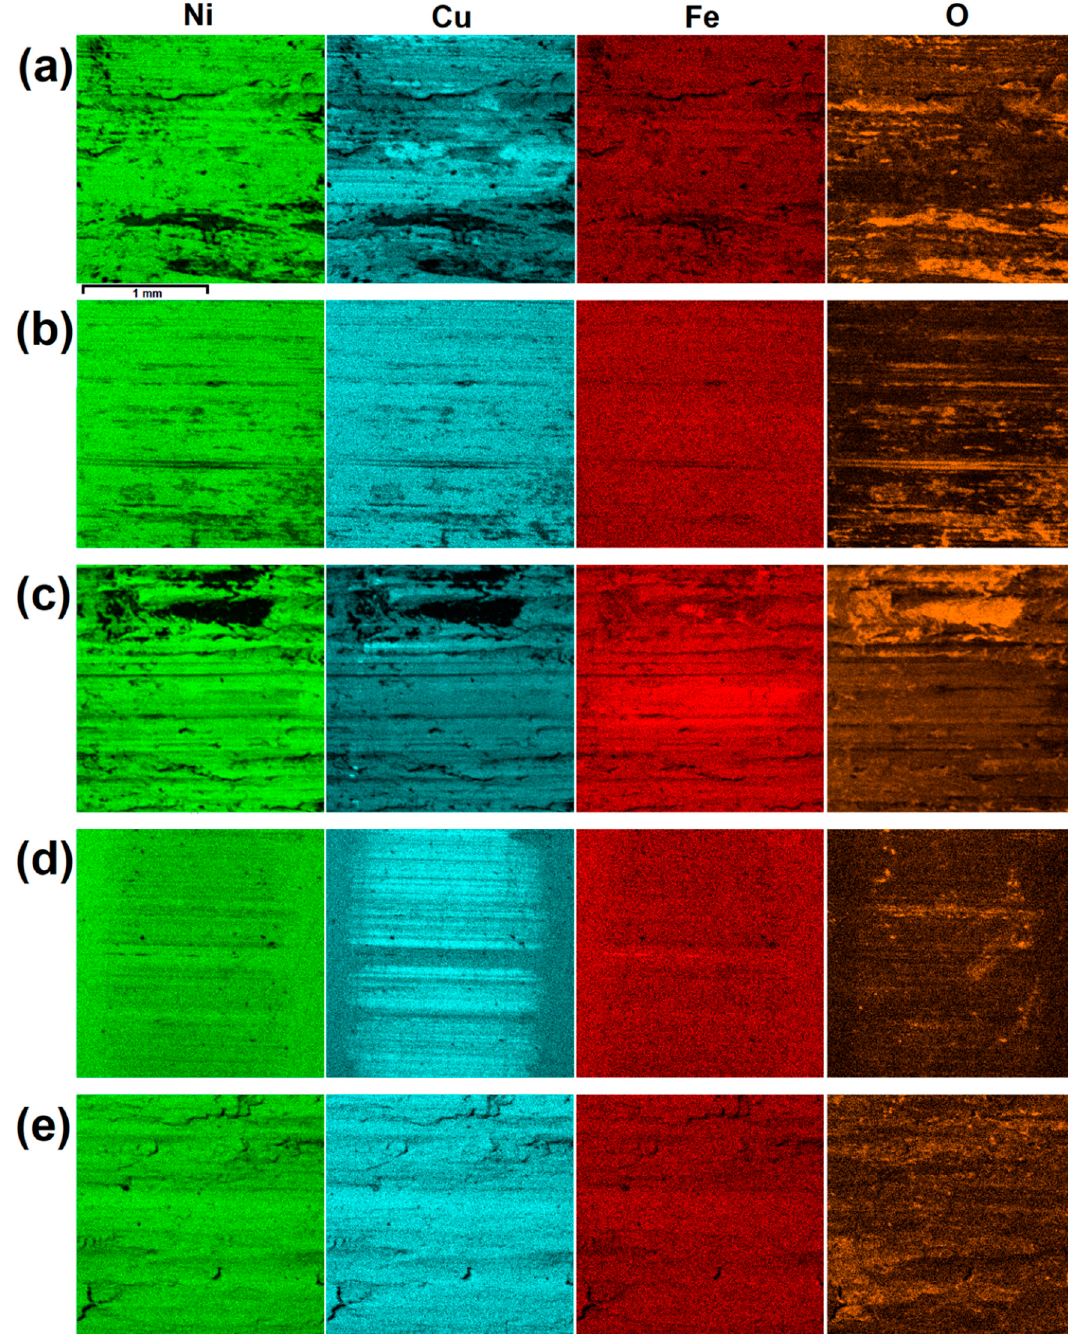
Figure 9. EDS mappings of surfaces after the wear test: ( a ) v l = 5 m/min and t b = 100 µm, ( b ) v l = 5 Figure9. EDSmappingsofsurfacesaftertheweartest: ( a )v l = 5m / minandt b = 100 µ m, ( b ) v l = 5 m / min m/min and t b = 200 µm, ( c ) v l = 50 m/min and t b = 100 µm, ( d ) v l = 50 m/min and t b = 200 µm, ( e ) and t b = 200 µ m, ( c ) v l = 50 m / min and t b = 100 µ m, ( d ) v l = 50 m / min and t b = 200 µ m, ( e ) untreated untreated Monel 400. Monel